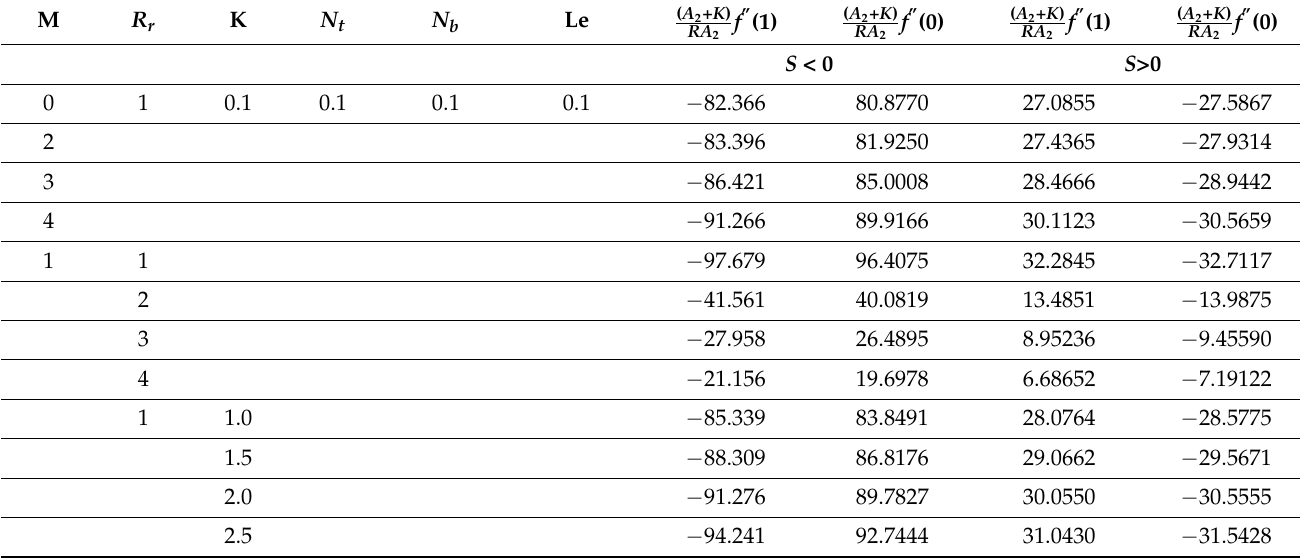
Table 4. Skin friction coefficient for ( γ Al 2 O 3 − C 2 H 6 O 2 ) , at lower and upper plane with strong interaction n = 0.